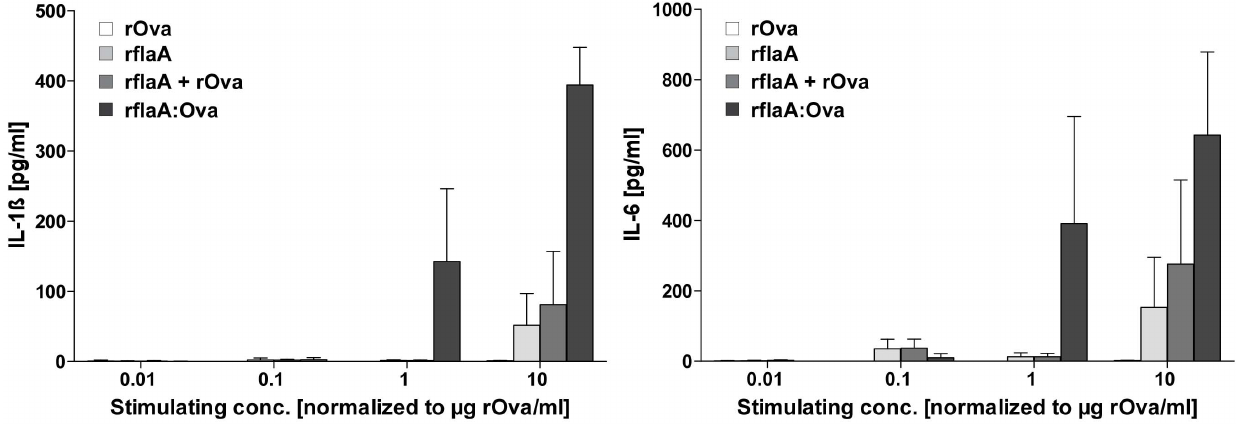
Figure 9. rflaA:Ova induces strong cytokine secretion from human monocytes. Monocyte activation test was performed using 5 m l of fresh blood stimulated with the indicated, equimolar protein amounts for 24 h. Supernatants were analysed for IL-1ß and IL-6 cytokine secretion by ELISA. Results are mean values 6 SD for four different donors.